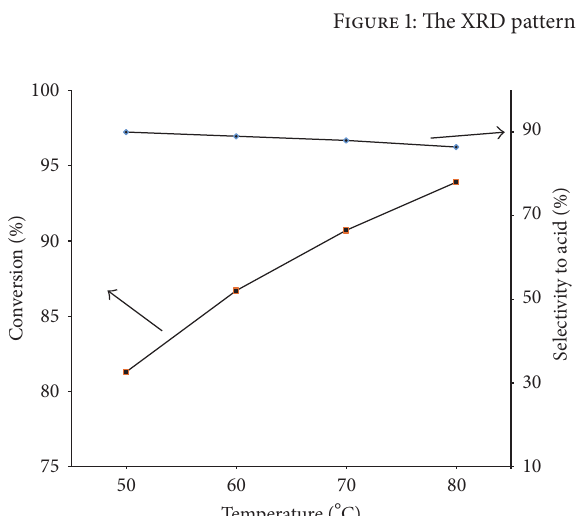
Figure 2: Effect of temperature on 2-hexenal oxidation using Au/MnO 2 . Reaction conditions: 4.23 g of 2-hexenal, 0.06 g of cat- alyst, 24h, atmospheric pressure.